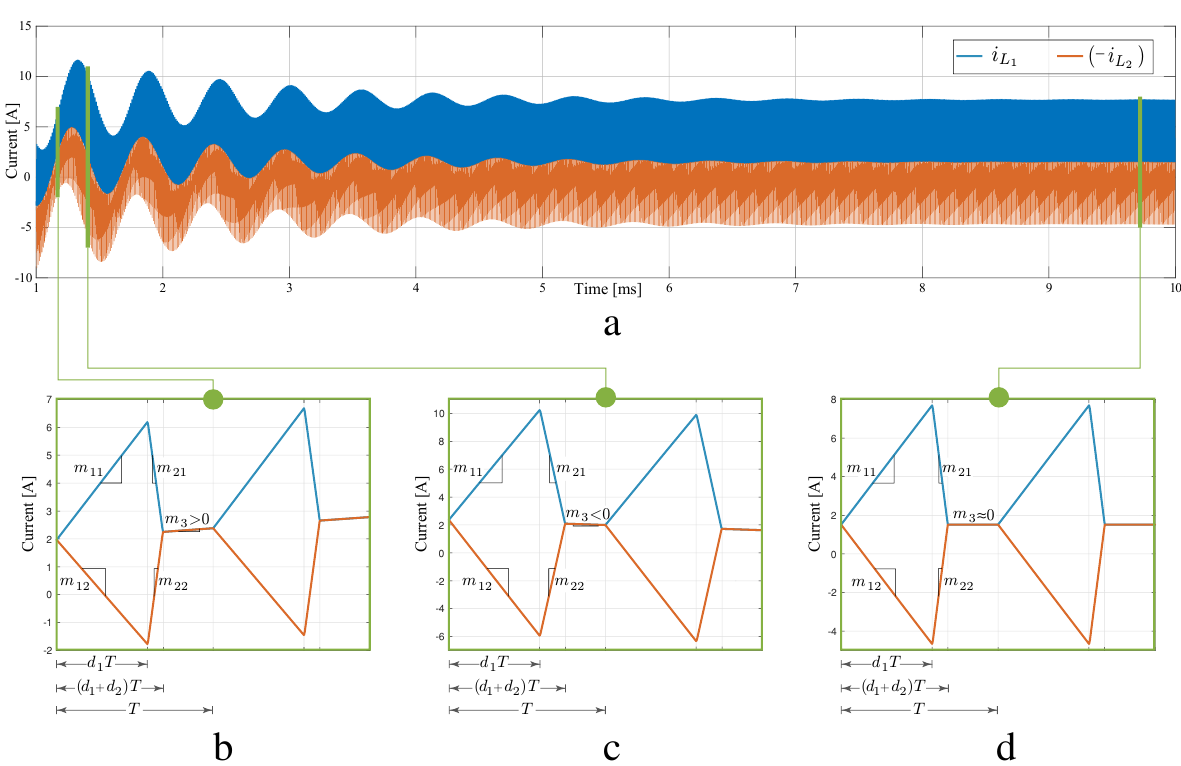
Figure 3. Responses in inductor currents: ( a ) dynamic response for inductor currents, ( b ) current transient with positive slope, ( c ) current transient with negative slope, ( d ) currents in steady